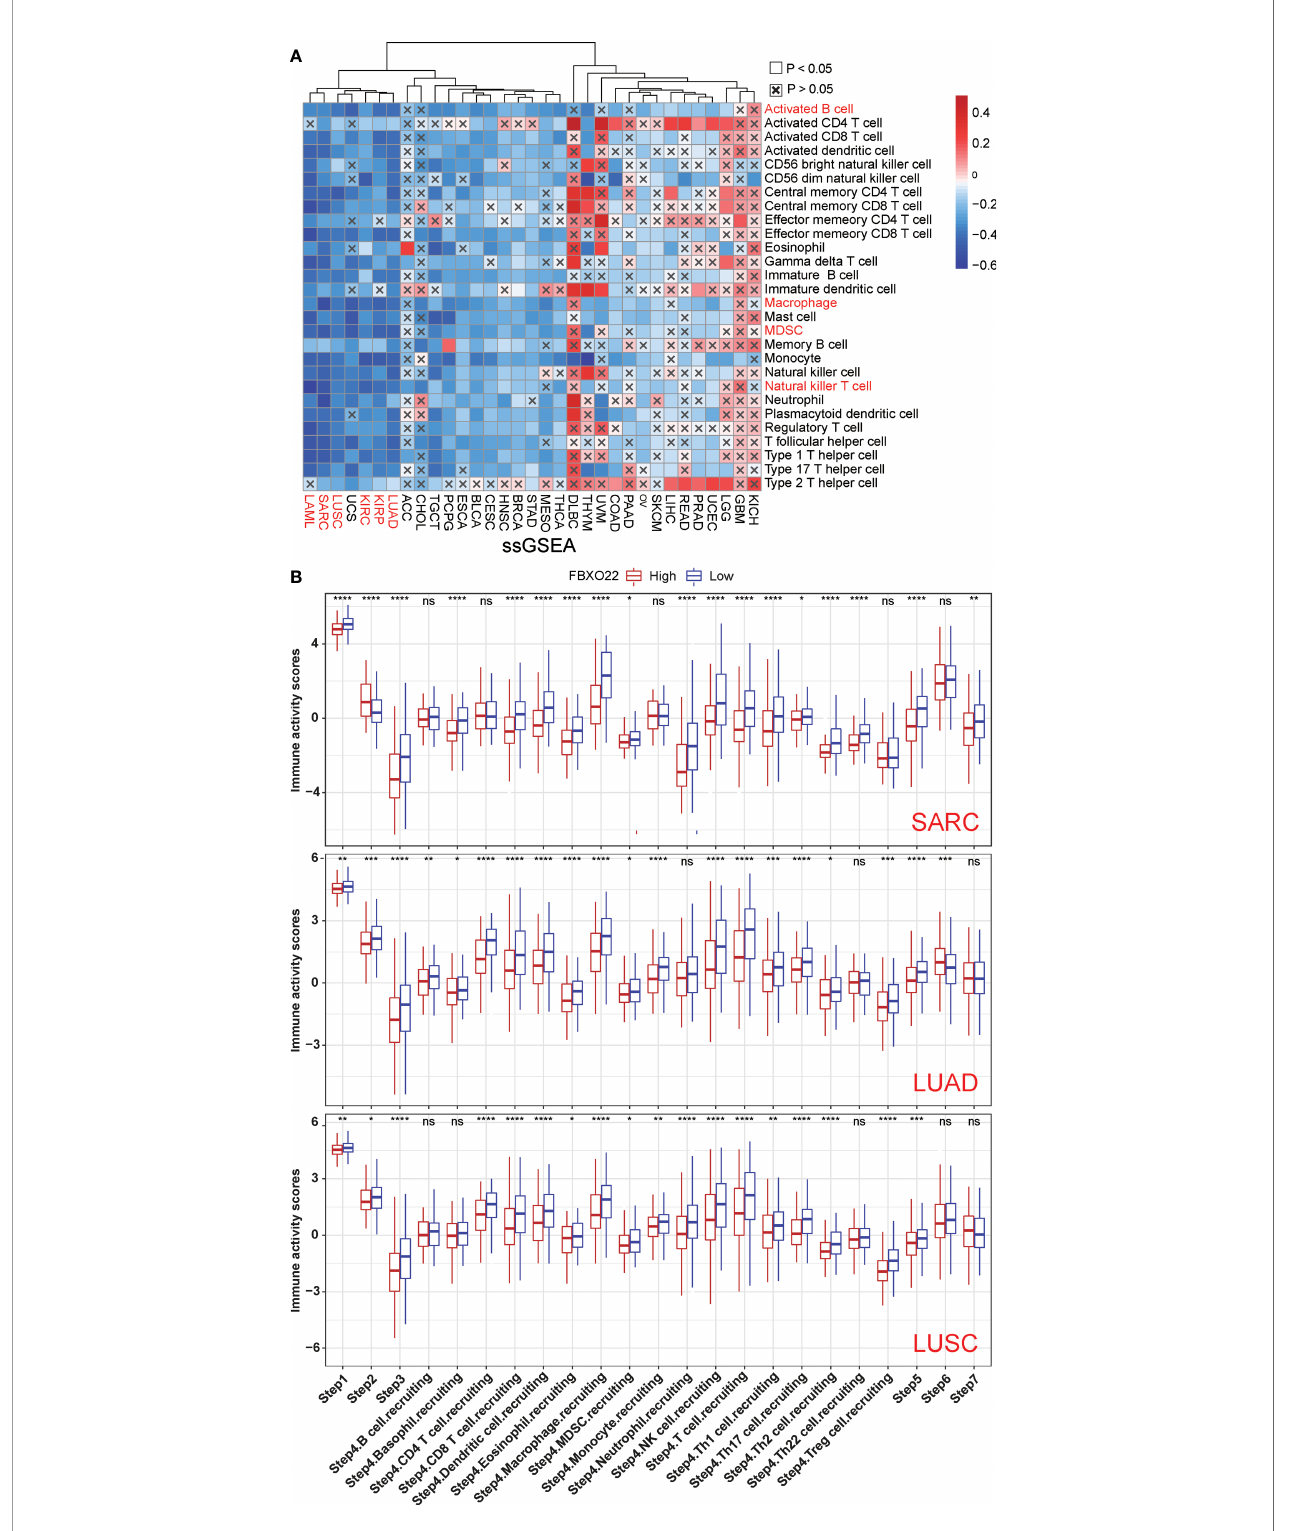
FIGURE 7 | The effect of FBXO22 on immunological status in pan-cancer. (A) Correlation between FBXO22 and 28 tumor-associated immune cells, as calculated using the ssGSEA algorithm. (B) Differences in the various steps of the cancer immune cycle between groups with high and low FBXO22 expression. ns, no signi fi cant difference; * p < 0.05; ** p < 0.01; *** p < 0.001; **** p <